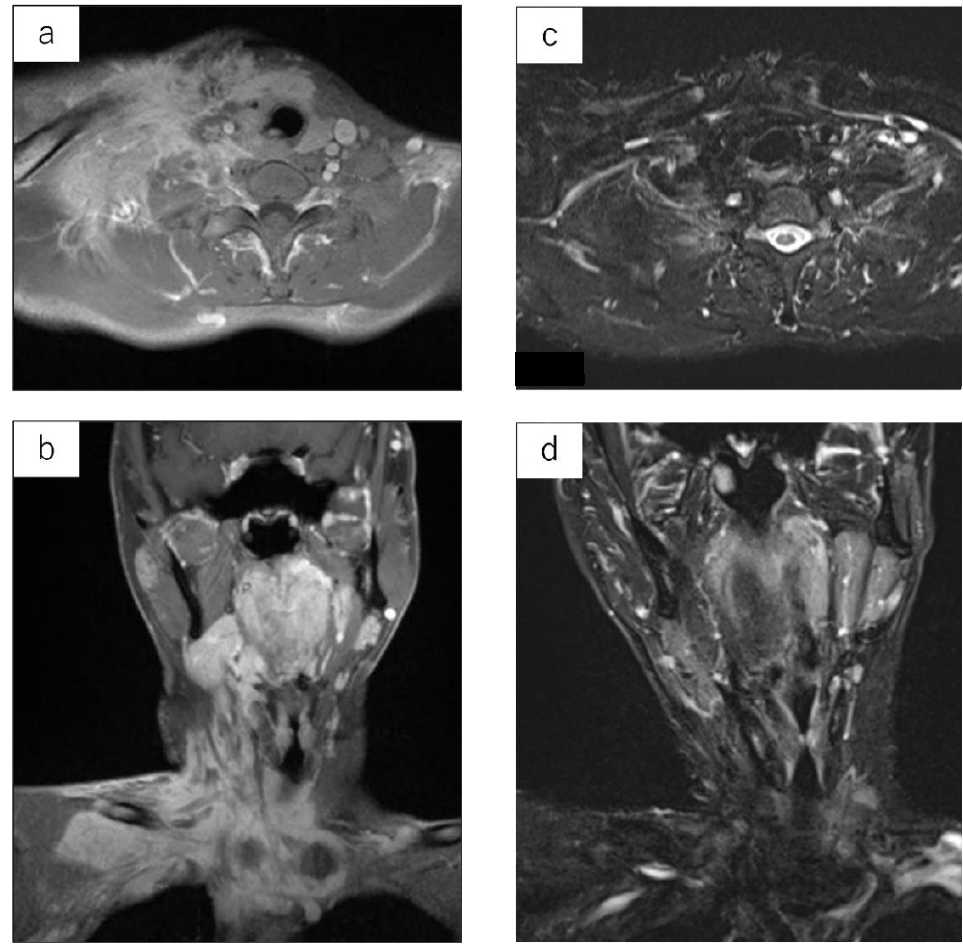
Figure 2. LGMS arising from the neck of a 29-year-old male. Contrast-enhanced MRI prior to irradiation. Signal changes are observed across a large area of the neck ( a , b ). MRI STIR image at 10.1 years after irradiation (IMRT: 60 Gy). The tumor has completely subsided ( c , d ). Table 2. Treatment and outcome of initial tumor.